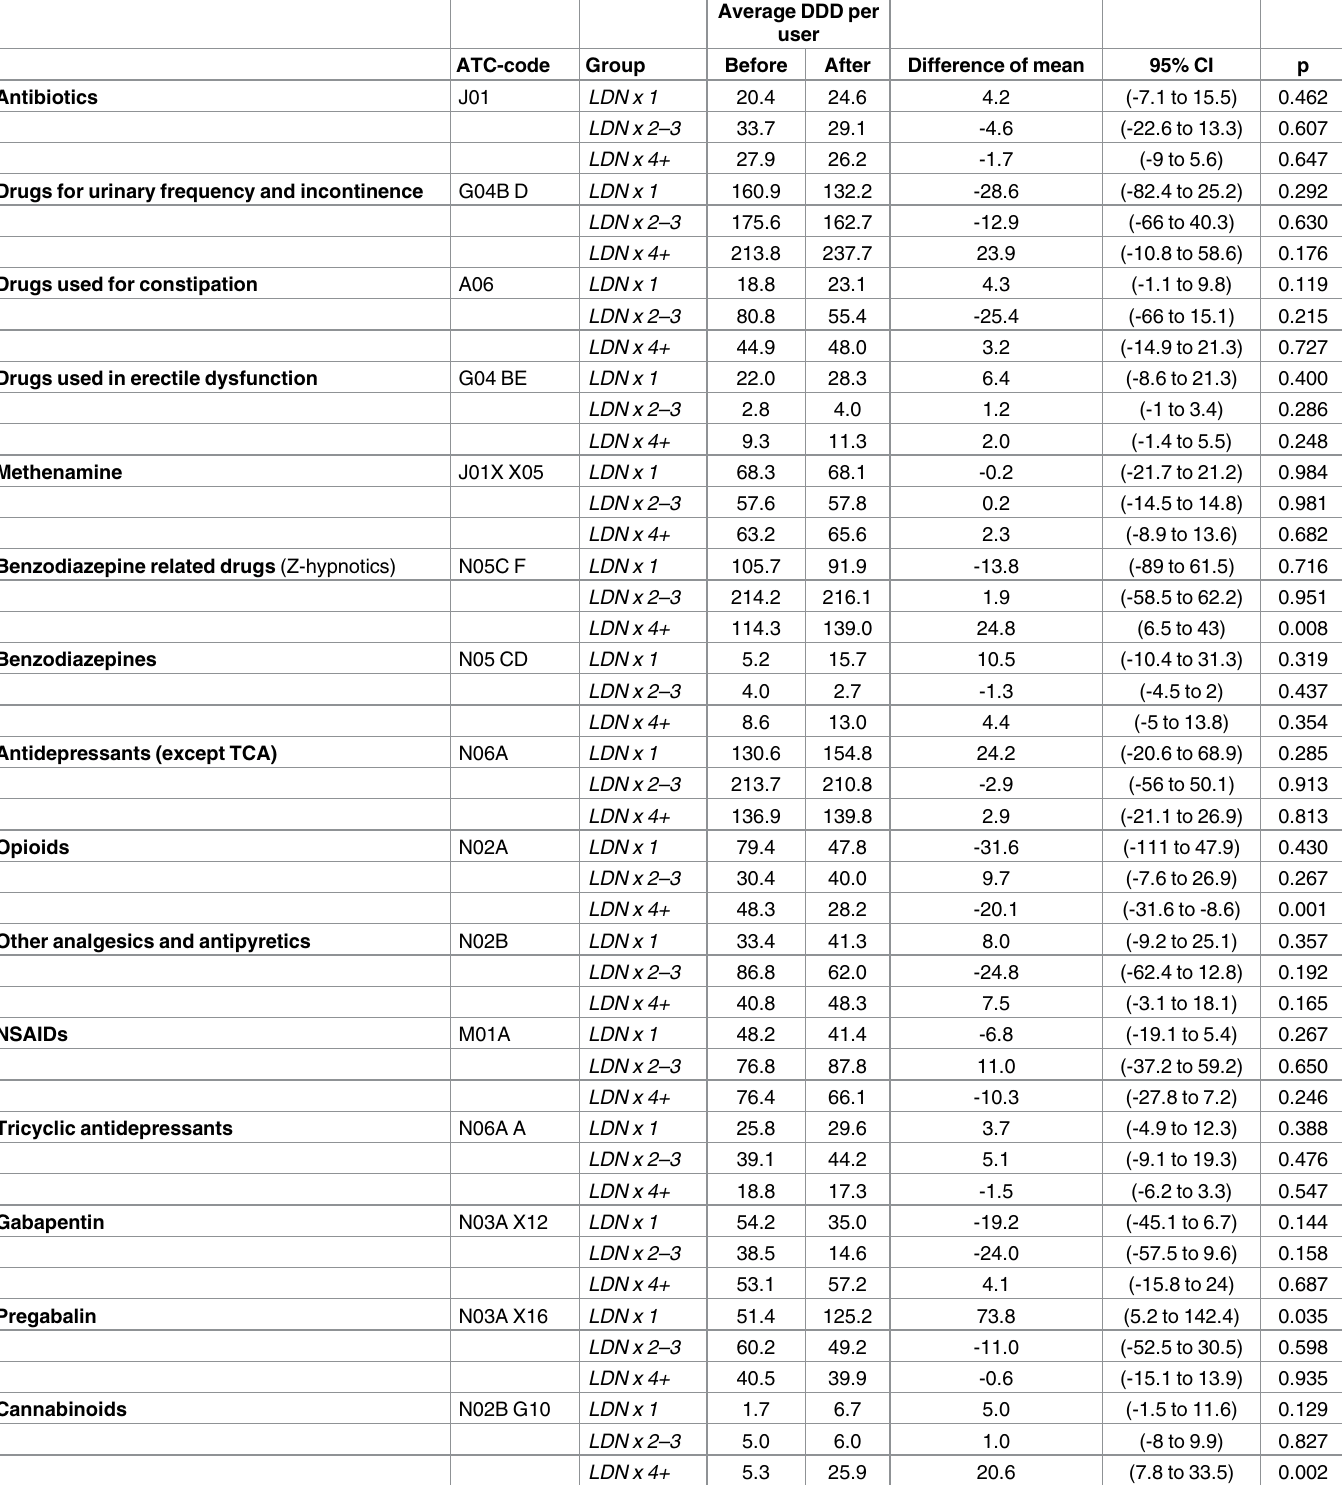
Table 3. Differencein use of drugs used to treat MS symptoms in defined daily doses (DDD) two yearsbefore and after initiation of LDN therapy by number of LDN dispenses to